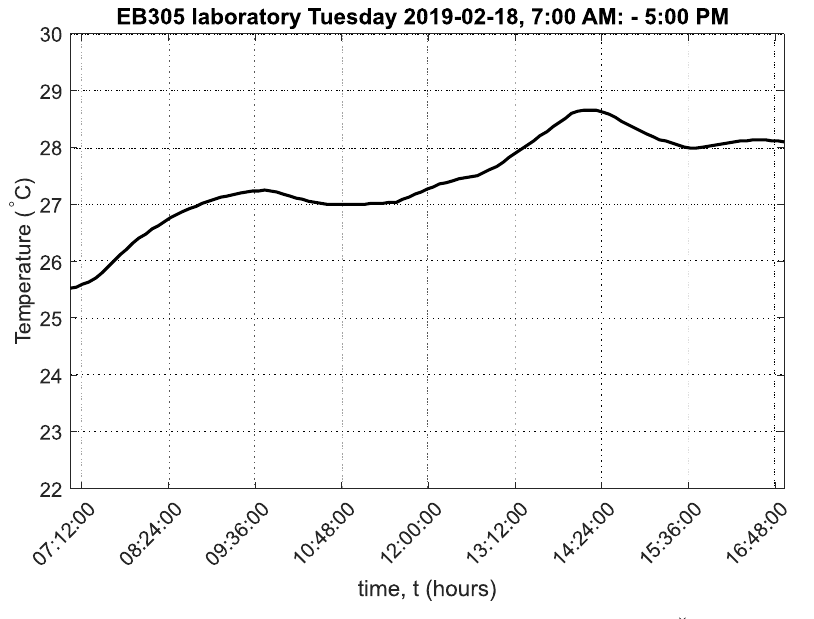
Figure A1. Graph of ambient temperature in laboratory EB305, VŠB-TUO.